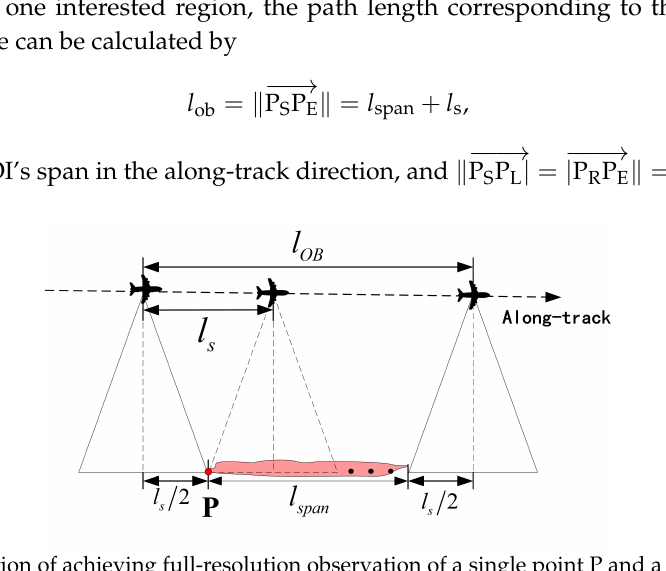
Figure 5. Illustration of achieving full-resolution observation of a single point P and a ROI whose span is l span